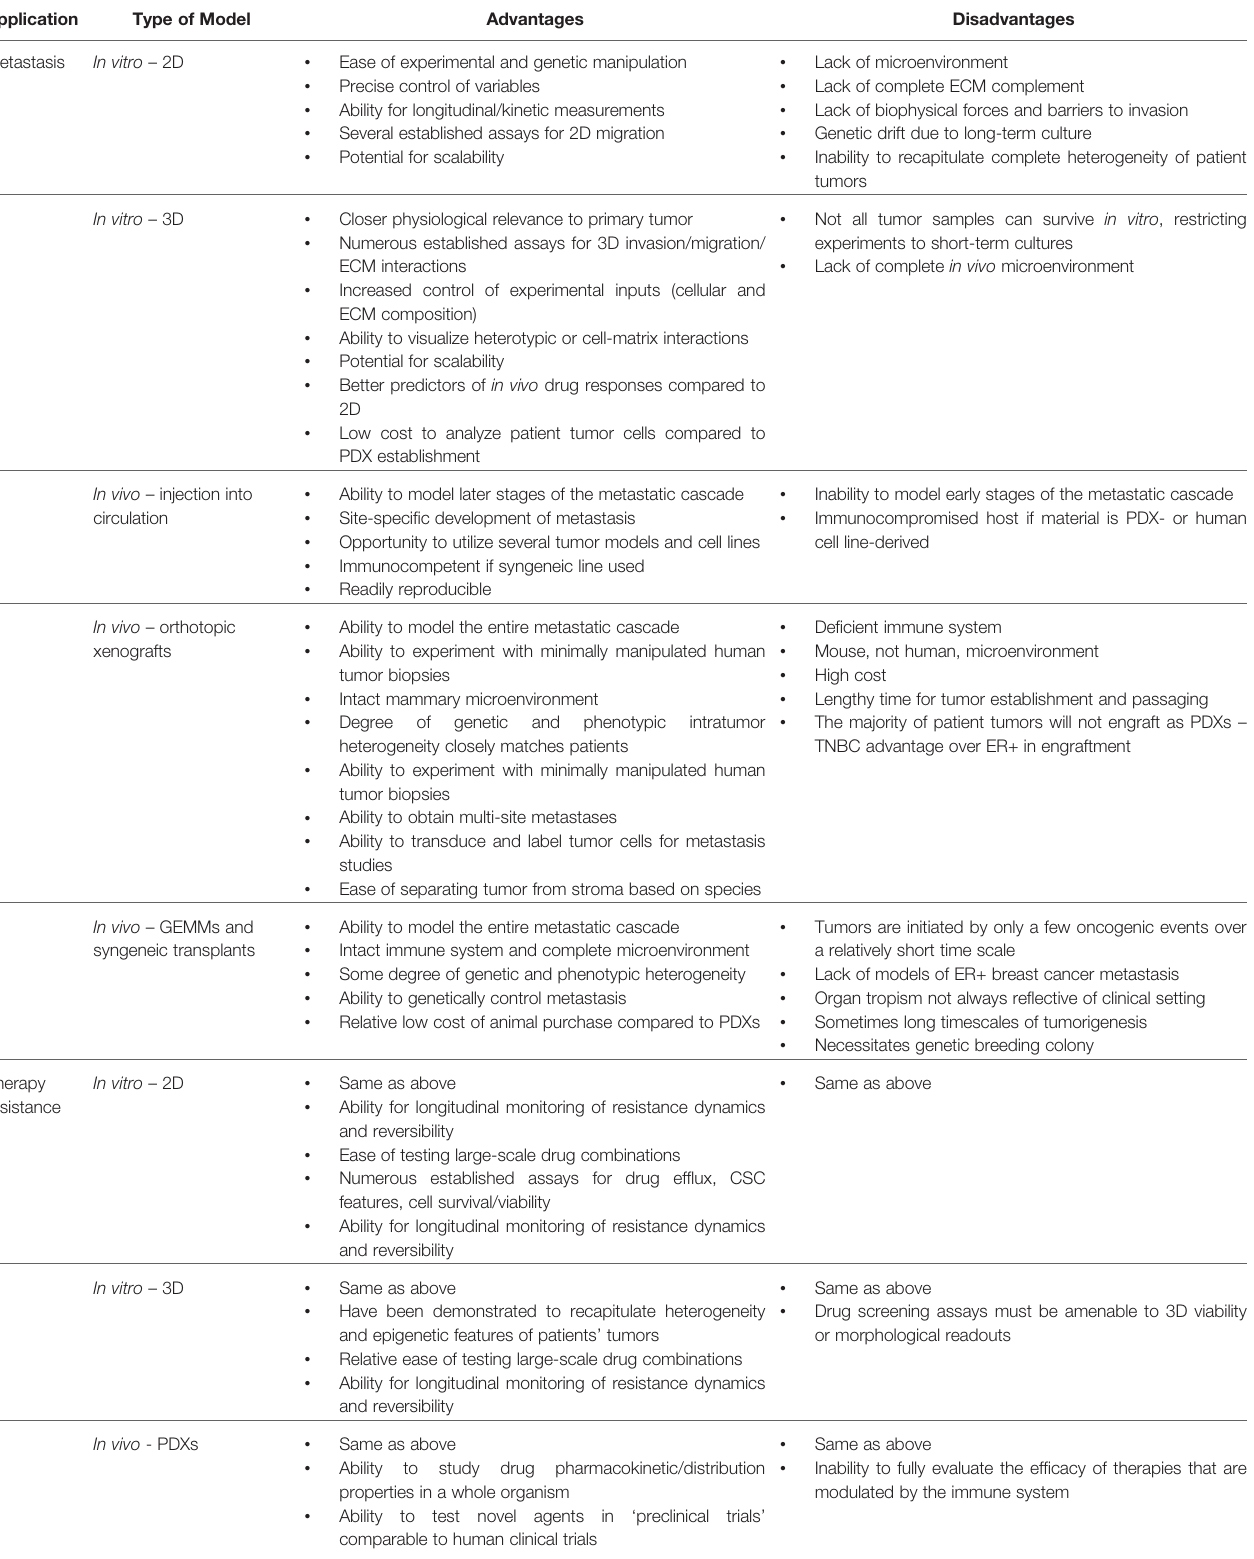
TABLE 1 | Bene fi ts and drawbacks of laboratory models to study breast cancer therapy resistance and metastasis.